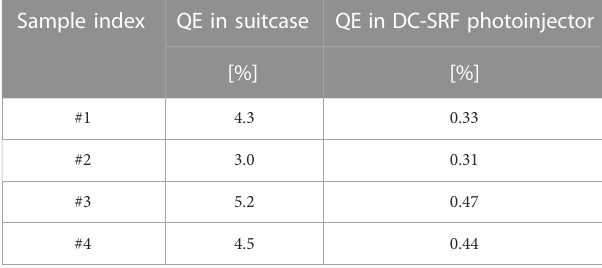
TABLE 1 Comparison of QE in the DC-SRF photoinjector and a suitcase for four K-Cs-Sb samples. Sample